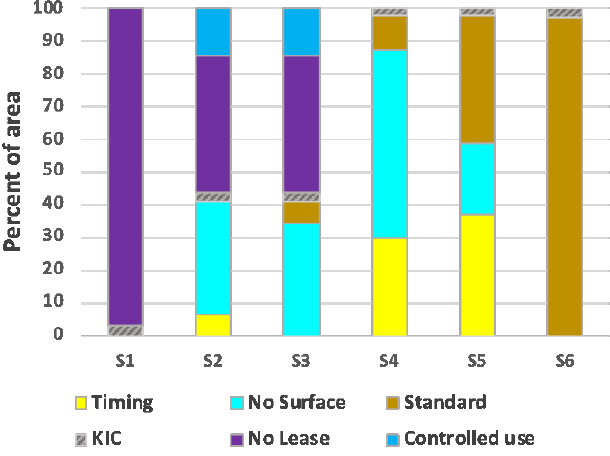
Fig. 5 . The percent of days, while on 1002 lands, collared caribou would spend in specific proposed lease stipulation areas for six development alternatives. “KIC” is Kaktovik Inupiat Land, native village corporation holdings within 1002 lands. Details of other stipulation areas explained in